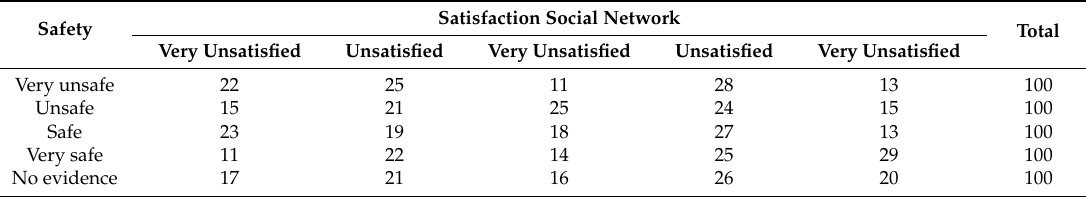
Table 12. Updated probabilities (in %) for satisfaction with social network based on neighborhood